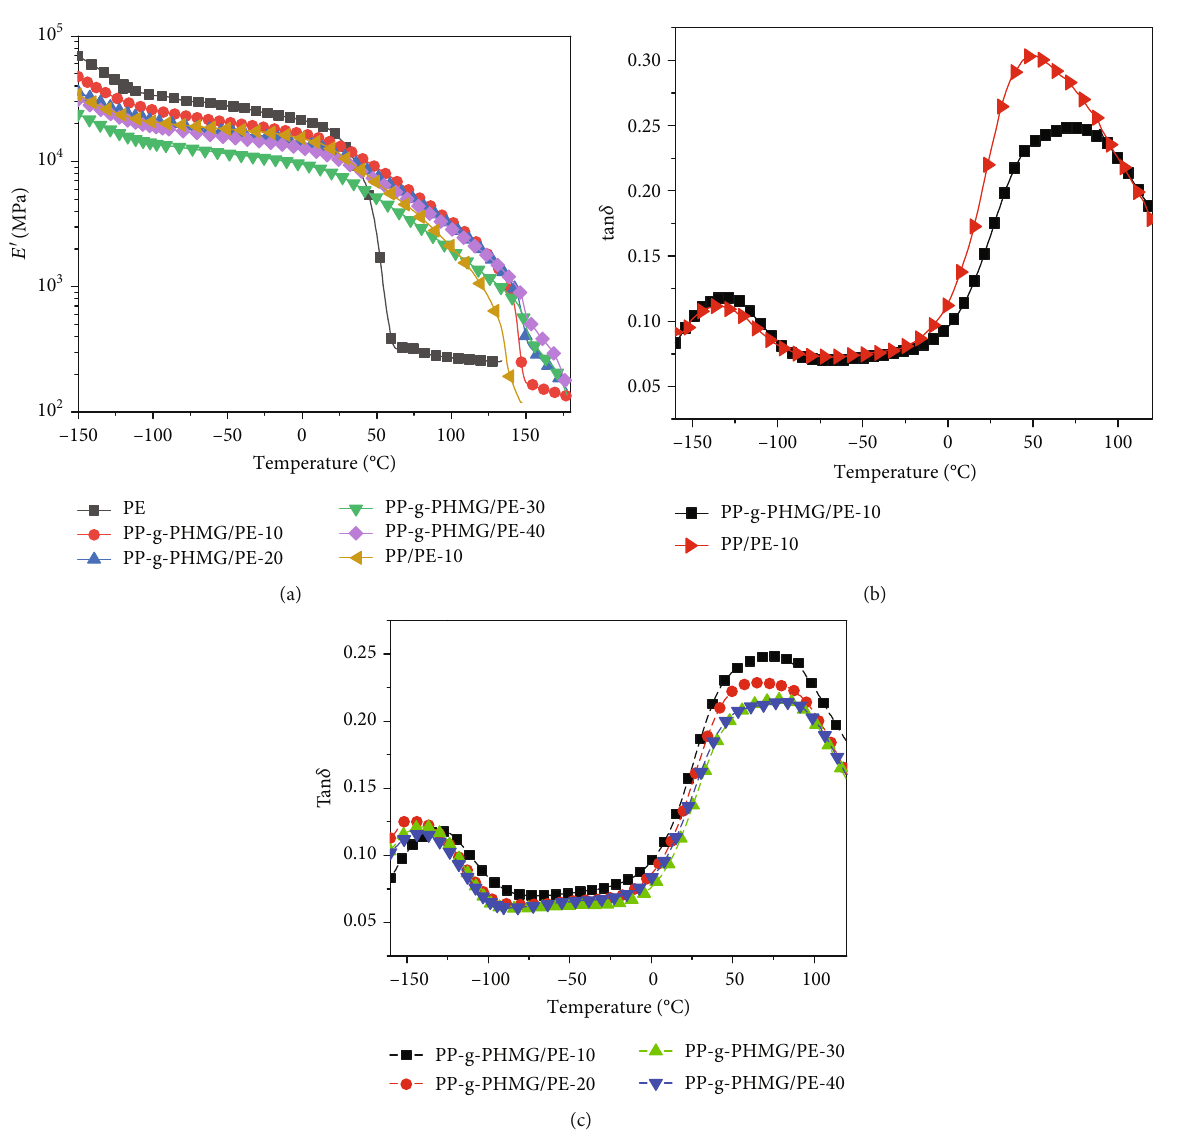
Figure 5: (a) The E ′ - T spectrum of the alloy mono fi lament, (b) the tan δ - T spectrum of the alloy mono fi lament with and without grafting PHMG, and (c) the tan δ - T spectrum of the PP-g-PHMG/PE alloy mono fi lament with di ff erent